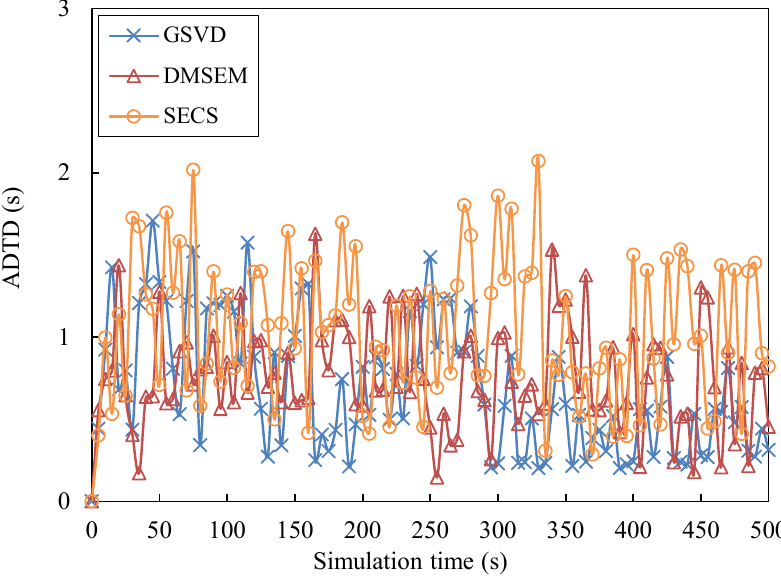
Figure 5. Average data transmission delay against simulation time.